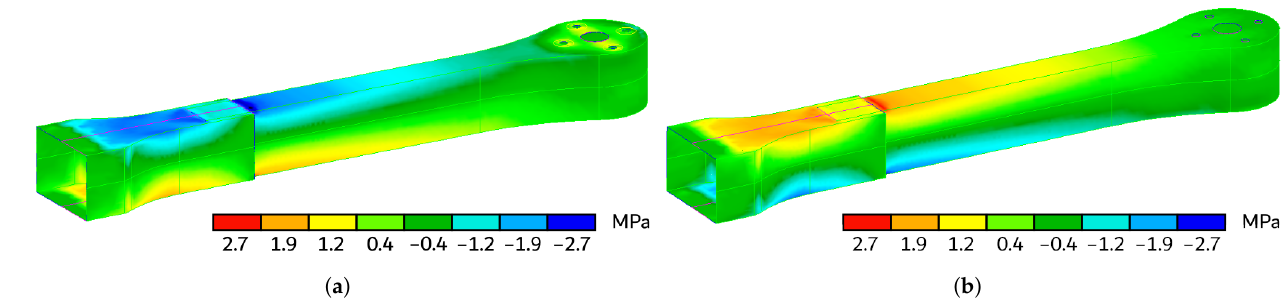
Figure 16. Axial component ( Y direction) of the stress tensor map, superimposed on the arm deformed shape. The results are expressed in MPa. ( a ) Top view. ( b ) Bottom view.